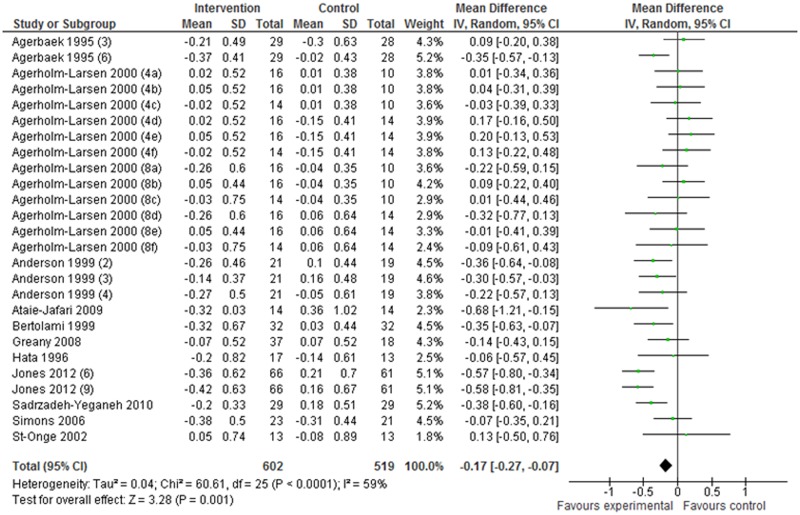
Effects of probiotics on changes in serum TC levels.Values in parentheses indicate intake duration (weeks). a, b, and c in parentheses indicate Gaio, Stra, and StLa vs PP, respectively; d, e, and f in parentheses indicate Gaio, Stra, and StLa vs PY, respectively. PP: placebo pill; PY: placebo yogurt; StLa: Streptococcus thermophilus and Lactobacillus acidophilus; StLr: Streptococcus thermophilus and Lactobacillus rhamnosus.